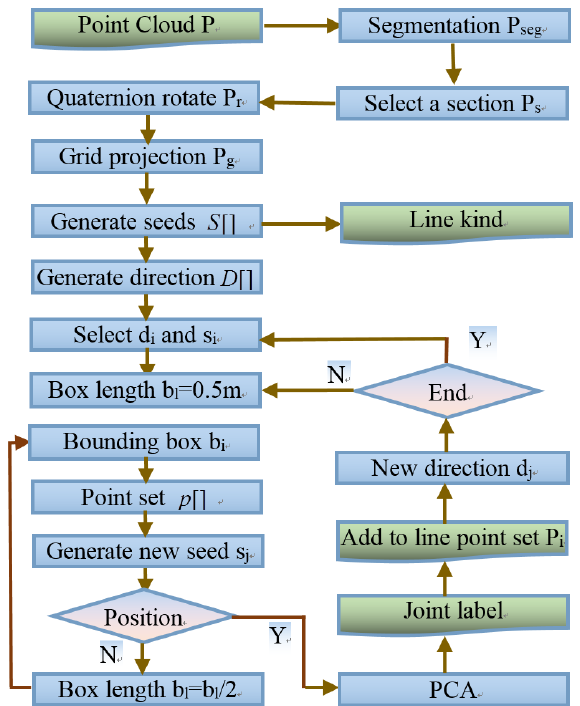
Figure 5. Point line extraction